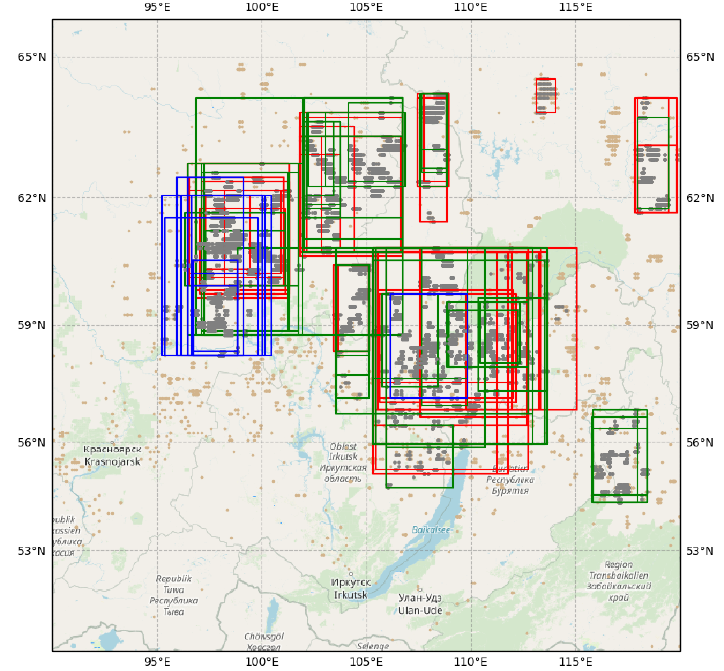
Figure 2. The forest fire clusters are obtained using the DBSCAN algorithm based on GFAS data from 1 June–31 August. Blue—groups existed from 1 to 15 July; red—16–31 July; green—1–12